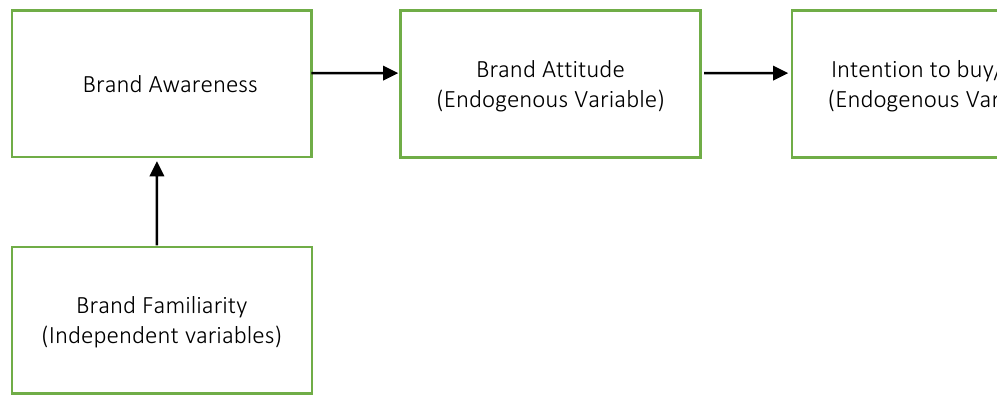
Figure 1. Operational model used for the purpose of the